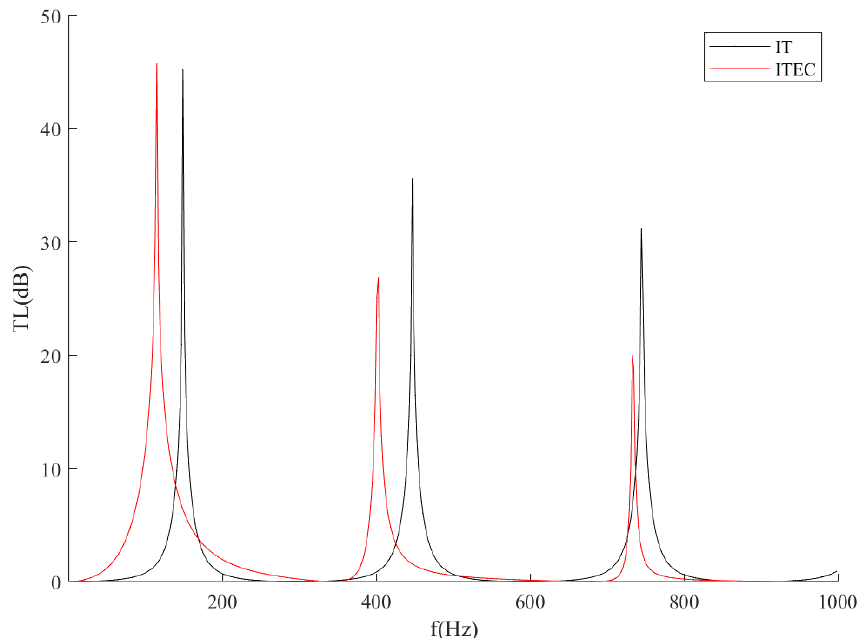
Figure 4. Comparison of transmission loss between the IT and ITEC; the black lines represent IT results, and red lines represent ITEC results.